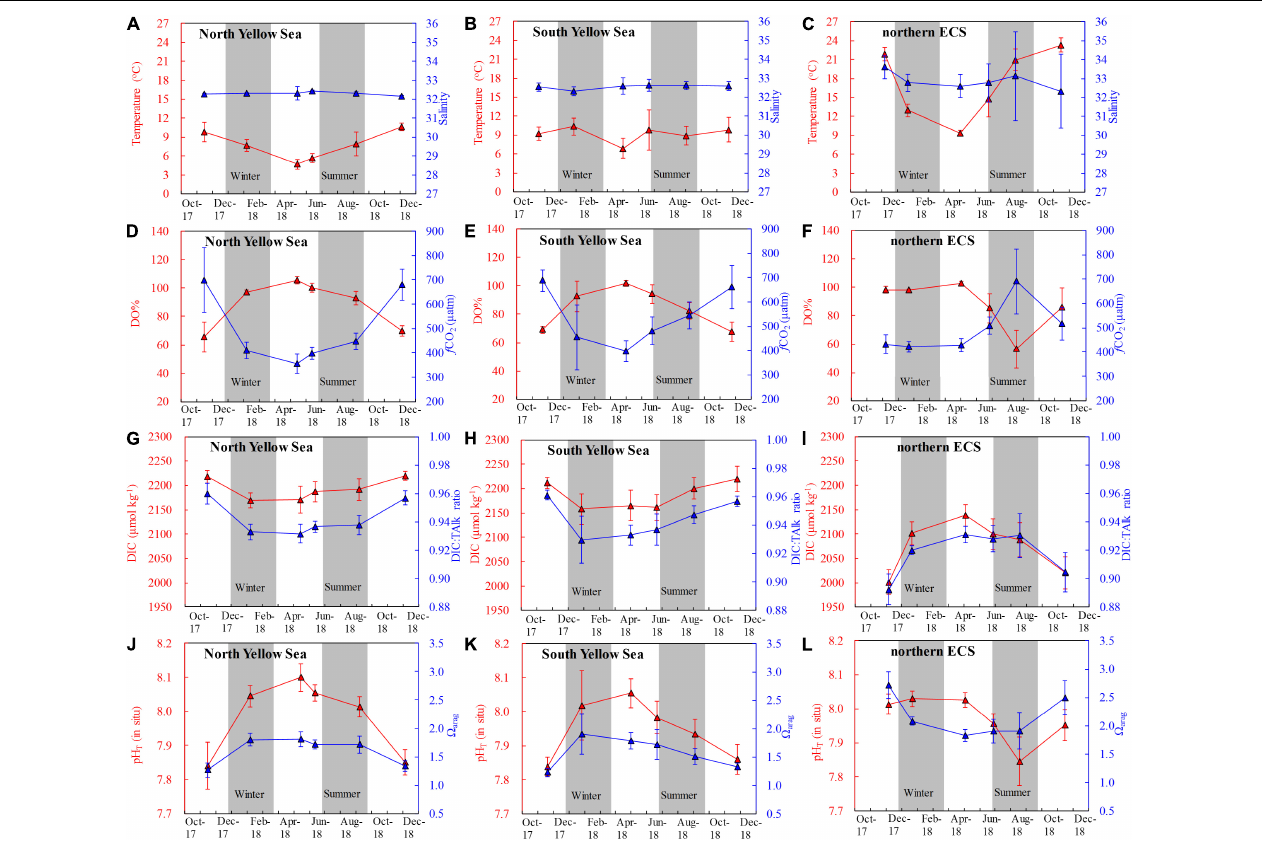
FIGURE 2 | Time series of survey-averaged values of bottom-water (A–C) temperature and salinity, (D–F) DO saturation (DO%) and fugacity of CO 2 ( f CO 2 ), (G–I) dissolved inorganic carbon (DIC) and DIC:TAlk ratio, and (J–L) pH T ( in situ ) and aragonite saturation state ( (cid:127) arag ). TAlk = Total alkalinity. Data points in the Yellow Sea during summer to autumn are within the YSCWM. Error bars denote standard